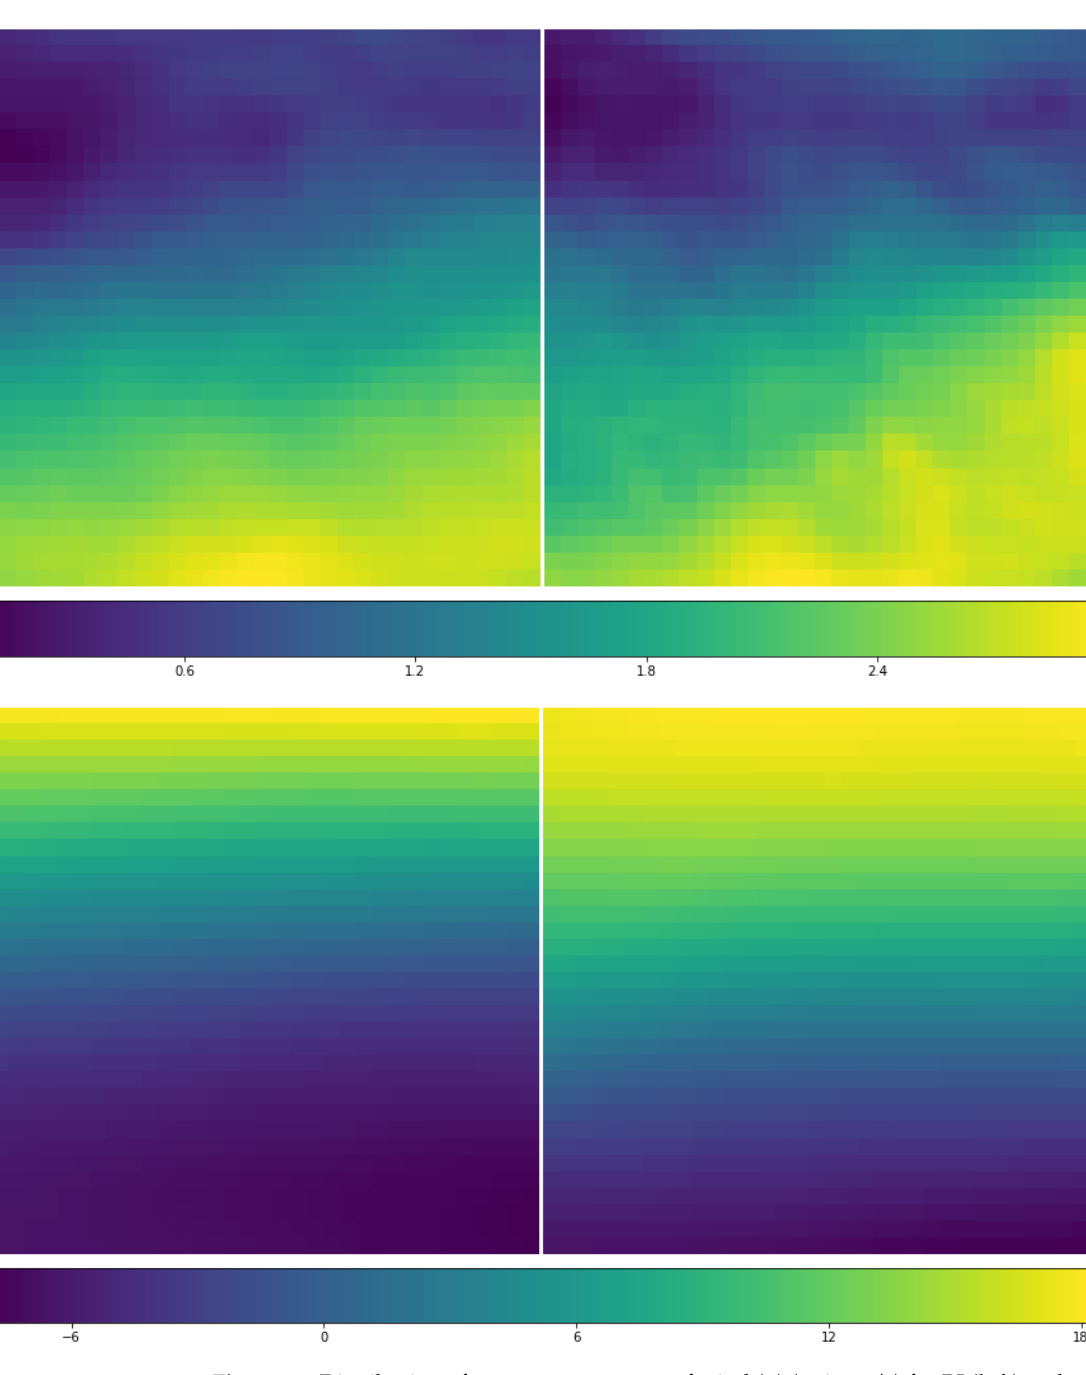
Figure 11. Distribution of mean u-component of wind (u) (unit: m/s) for RI ( left ) and non-RI cases ( right ) based on 584 RI cases and randomly selected 584 non-RI samples at ( top ) 850 hPa and ( bottom ) 200 hPa. The X-axis and Y-axis are aligned as in Figure